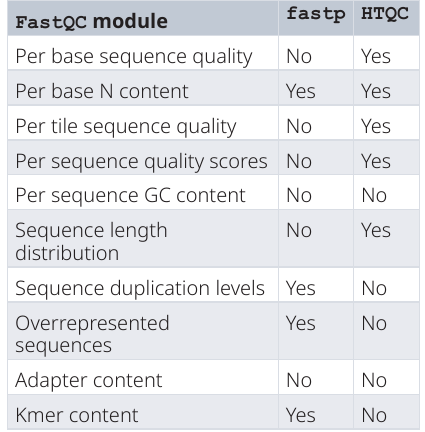
Table 1. Comparison of analysis modules provided by fastp and HTQC , two commonly used QC software